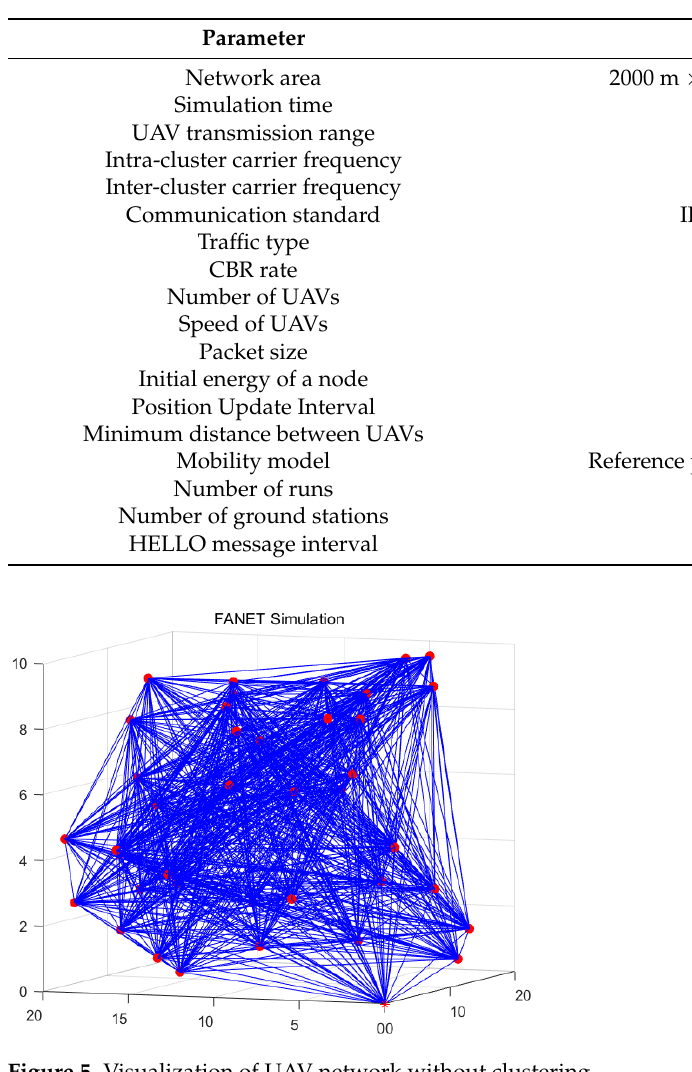
Figure 5. Visualization of UAV network without clustering.